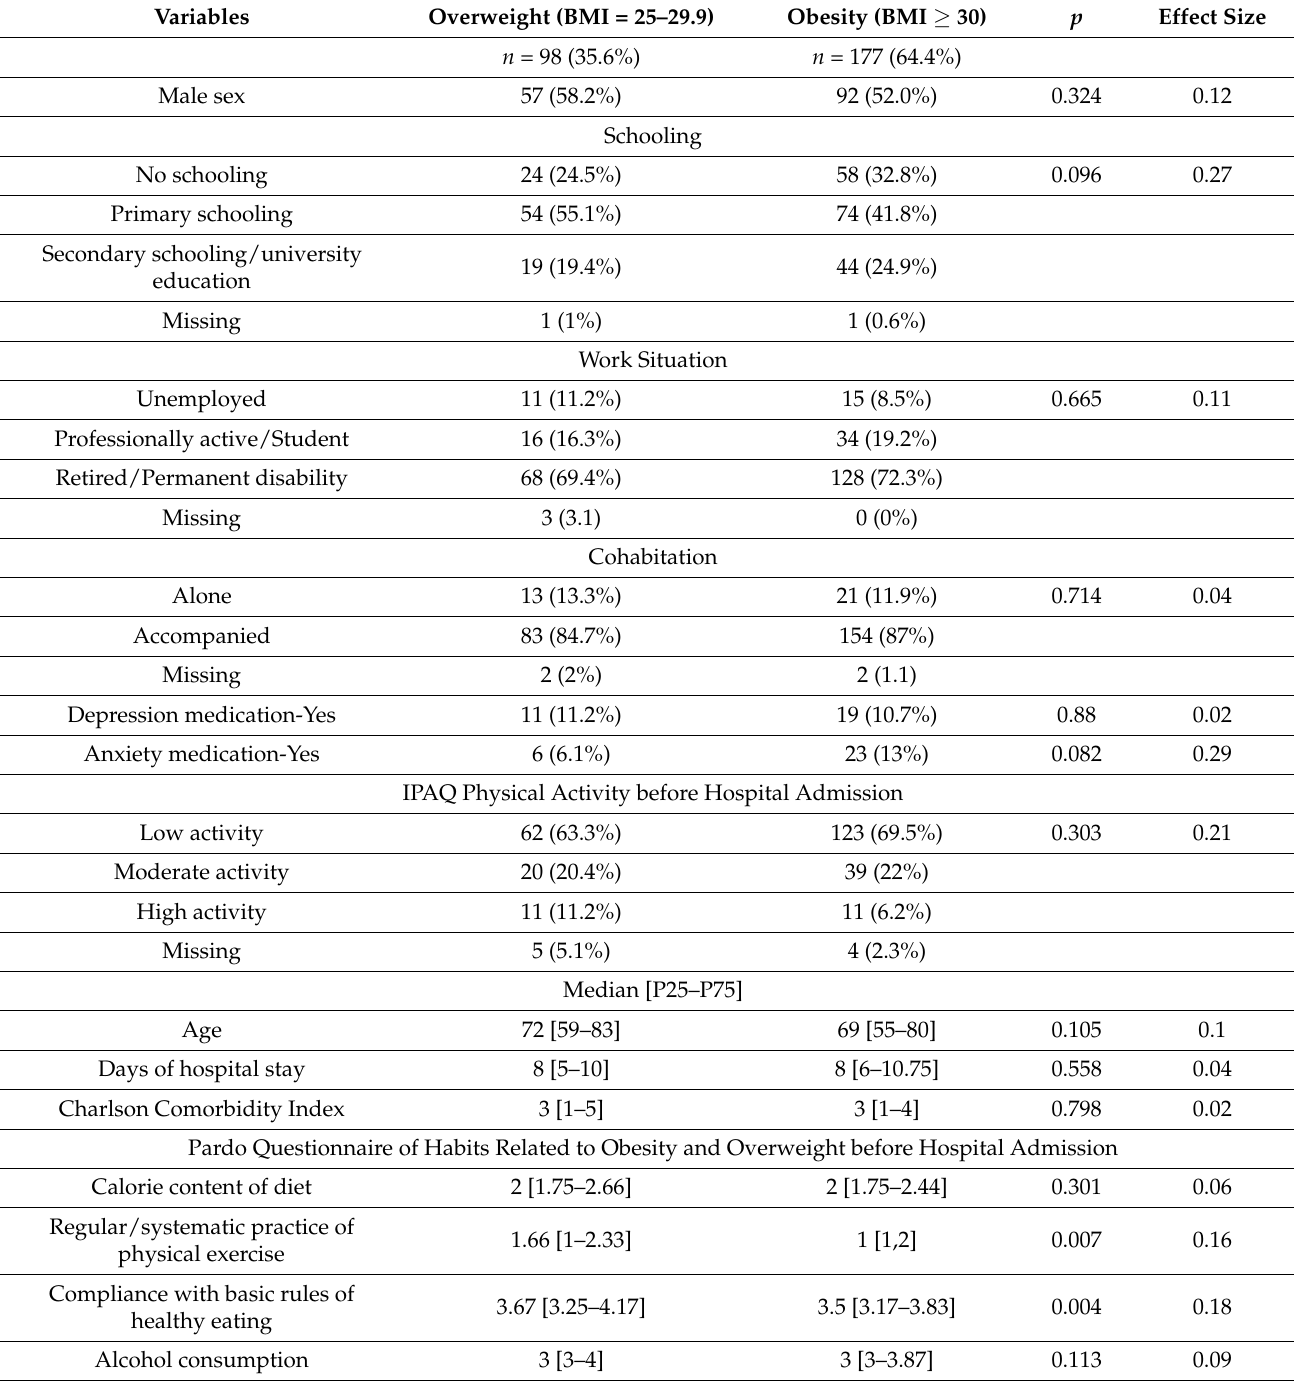
Table 1. Descriptive variables considered and bivariate analysis between patients with overweight and